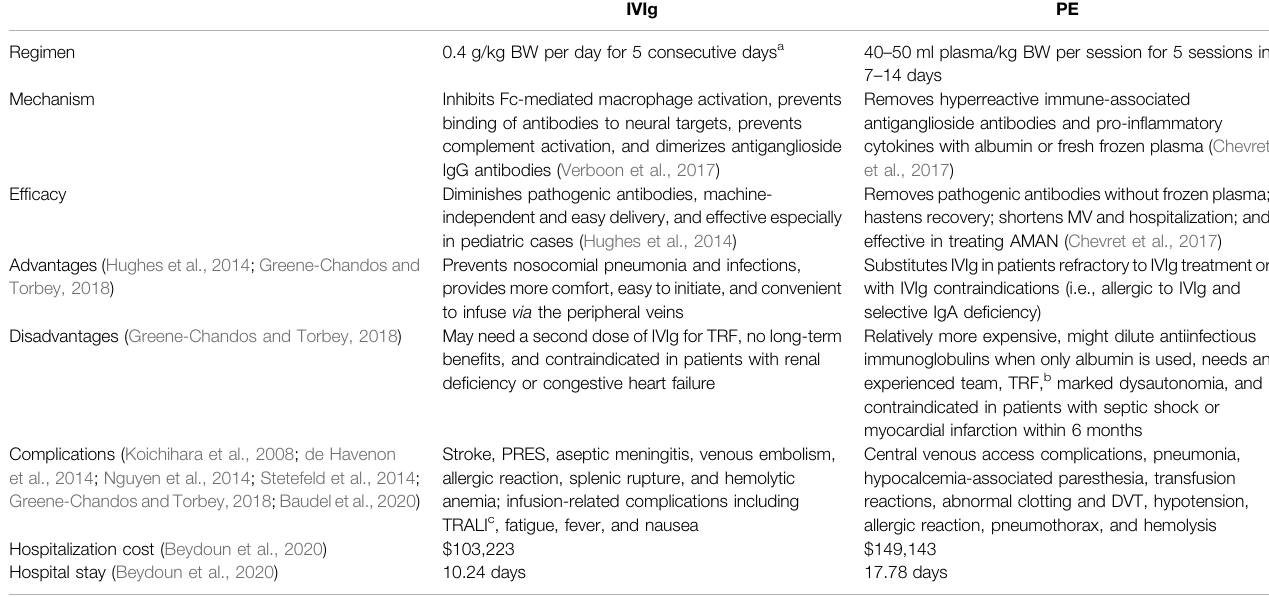
TABLE 2 | Comparisons between IVIg and PE.